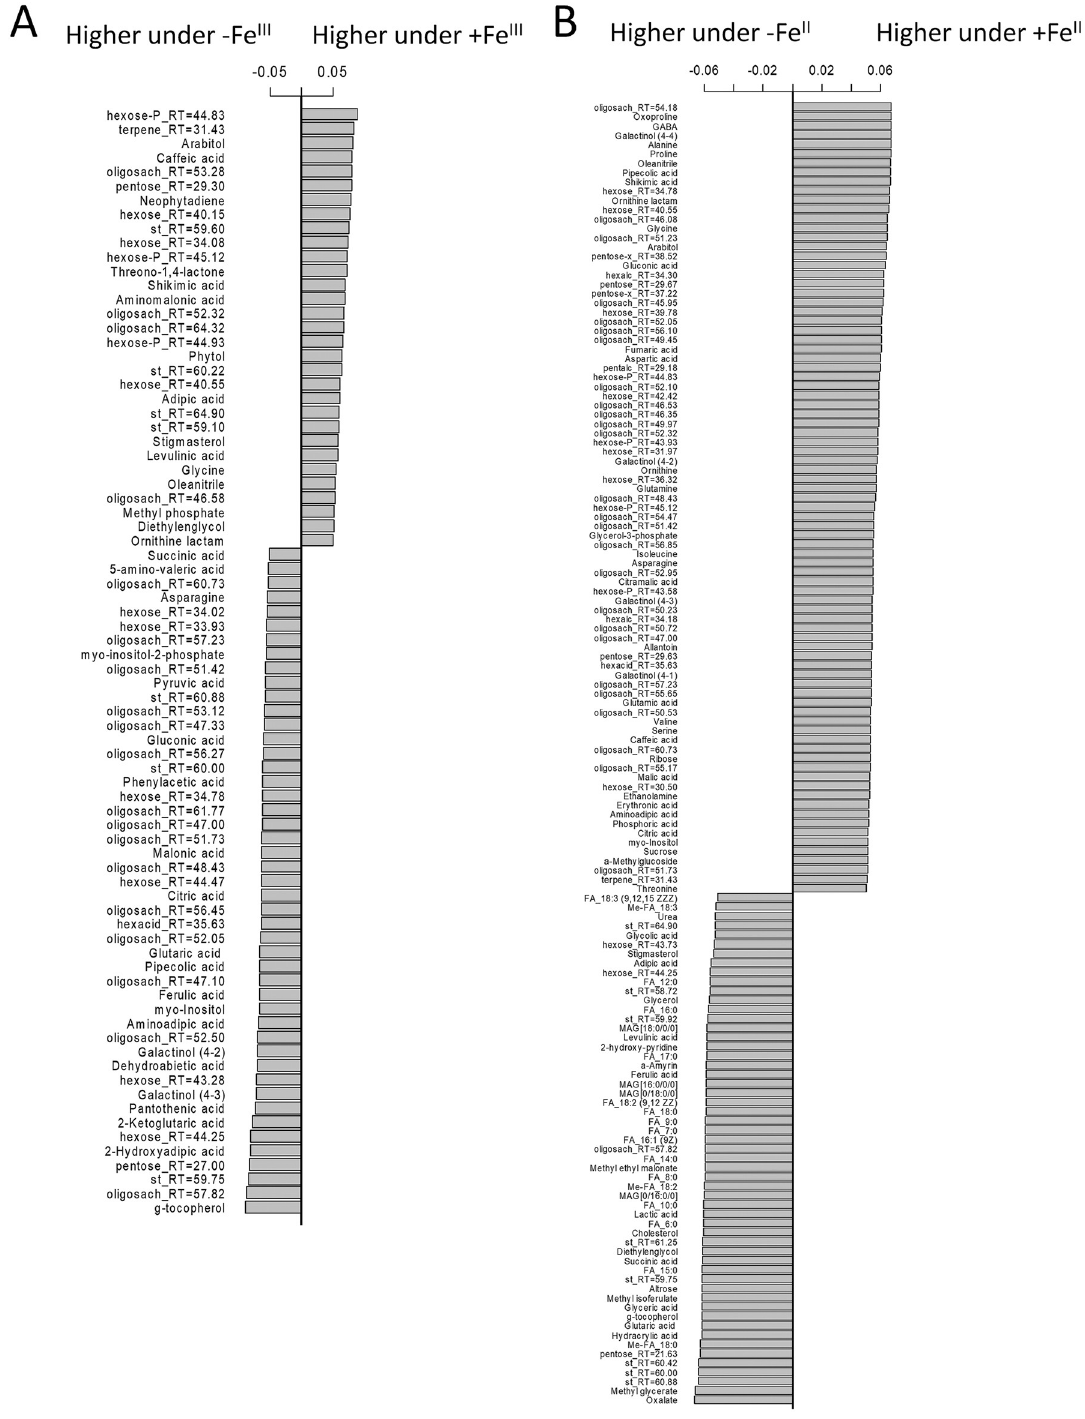
Fig 6. Selection of features discriminating leaf metabolome of the +Fe and − Fe cucumber plants grown hydroponically in a nutrient solution, either with (+Fe II and +Fe III ) or in Fe-free ( − Fe II and − Fe III ) nutrient solution for 10 days. Bar plots of loadings of predictive component (VIP > 1) derived from OPLS-DA comparing of metabolomes of cucumber grown with different Fe species: A— Fe III plants, B—Fe II plants.